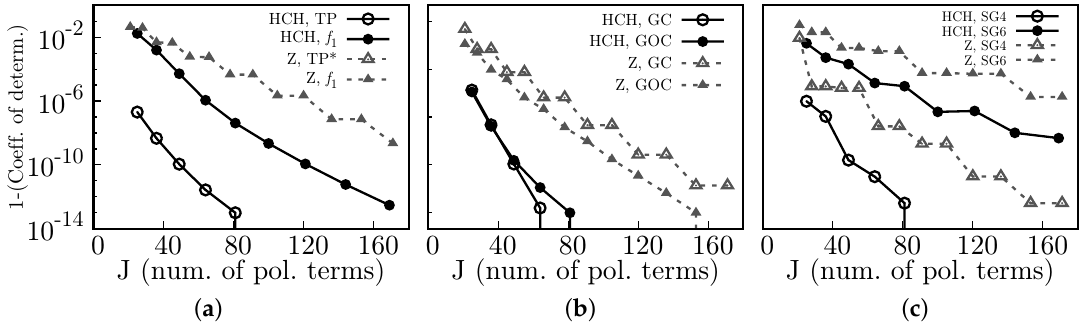
Figure 6. Compared accuracy (1-(Coefficient of determination)) vs. J (number of polynomial terms) between Half Circular Harmonics (HCH) and the Zernike (Z])polynomials, for the test functions ( a ) Tilted Plane (TP/TP*), f 1 , ( b ) a centered Gaussian (GC), an off-centered Gaussian (GOC), and ( c ) super-Gaussians of order 4 (SG4) and 6